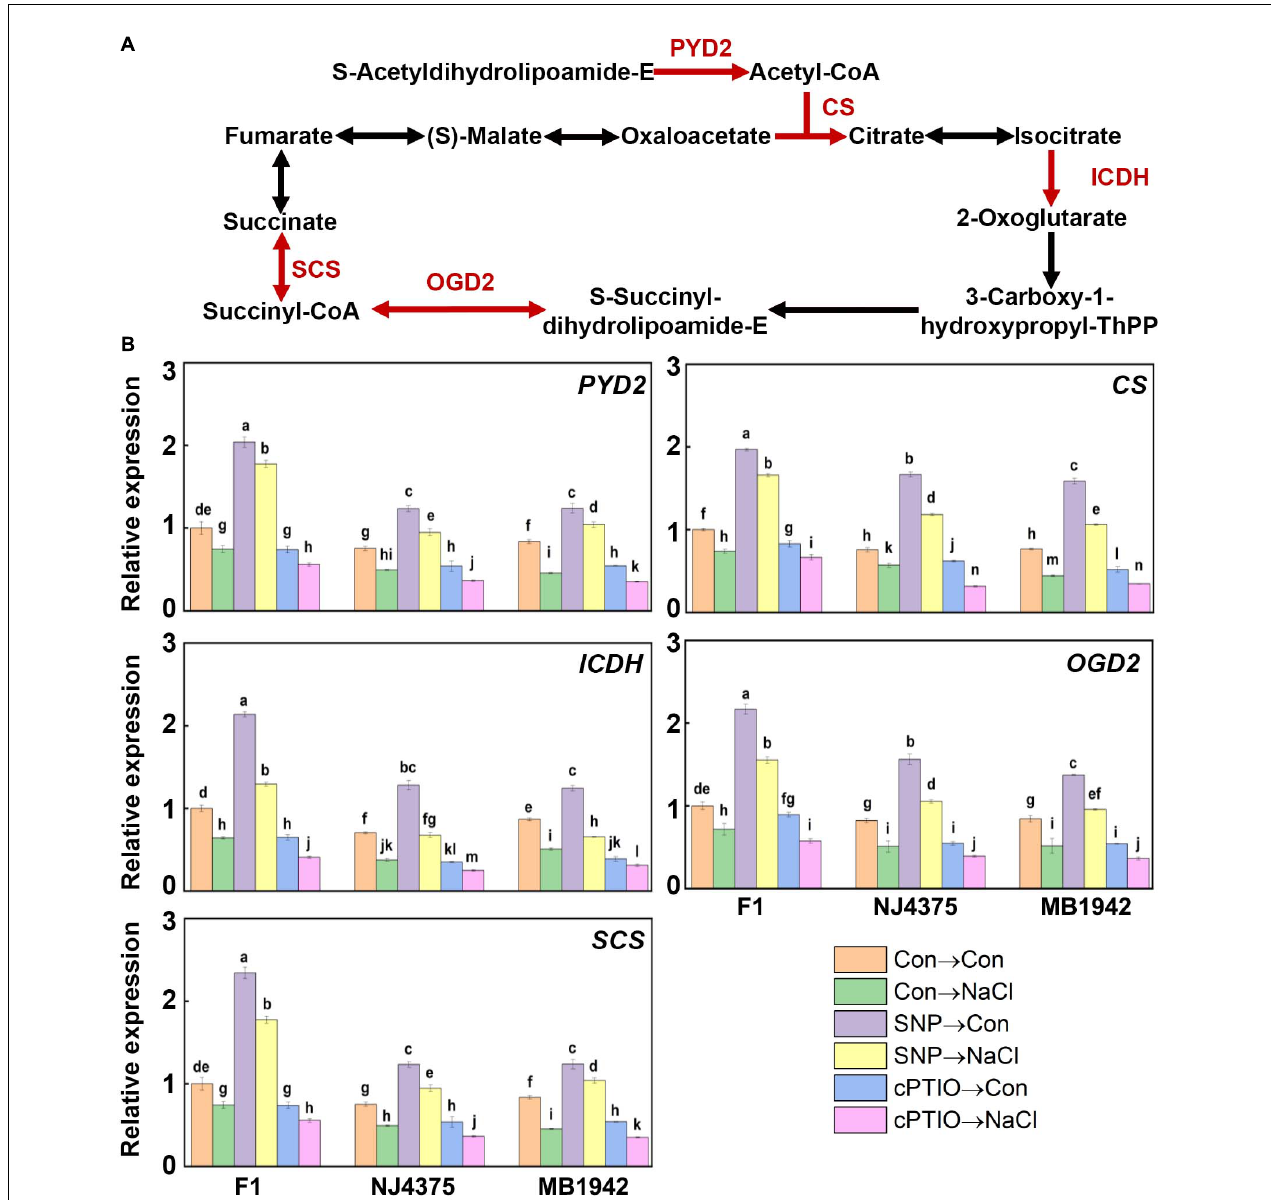
FIGURE 7 | NO-modulated TCA cycle metabolic process. (A) The proteins were extracted from the leaf tissues after treated for 3 days. TCA cycle metabolic-related proteins were identified by LC-MS/MS. The up-regulated proteins, including dihydrolipoamide acetyltransferase (PYD2), citrate synthase (CS), isocitrate dehydrogenase (ICDH), dihydrolipoamide succinyltransferase (OGD2), and succinyl-CoA synthetase (SCS) associated with NO in the hybrid, are shown in red (data obtained from Supplementary Table 2 ). (B) After treated for 1 day, the expression profiles of the corresponding genes in the leaves of F1 and two parents were analyzed by qPCR. Values are the means ± SD for three independent experiments. One-way ANOVA analyses were conducted according to Duncan’s multiple range test. Different letters denote significant differences at P <